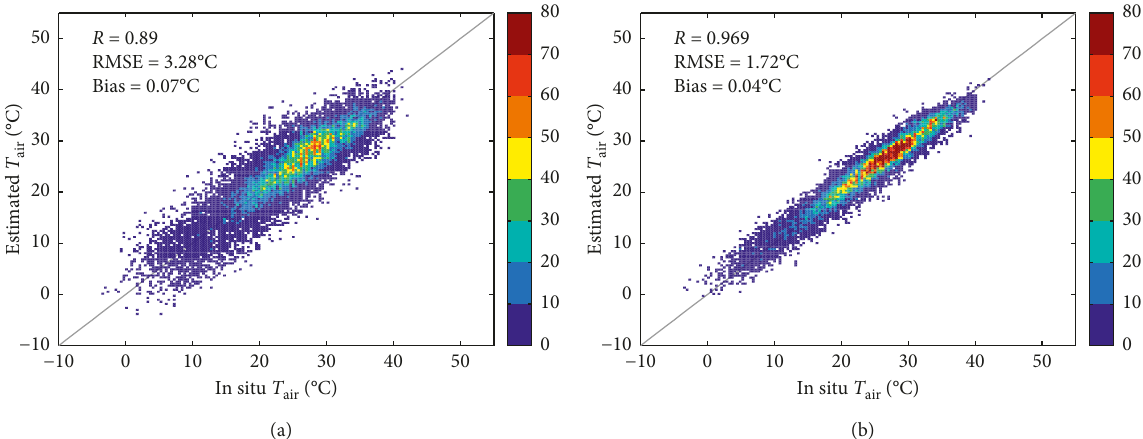
Figure 2: Two-dimensional histogram for estimated T air versus observed T air at the meteorological sites for linear (a) and NN (b) model 9.